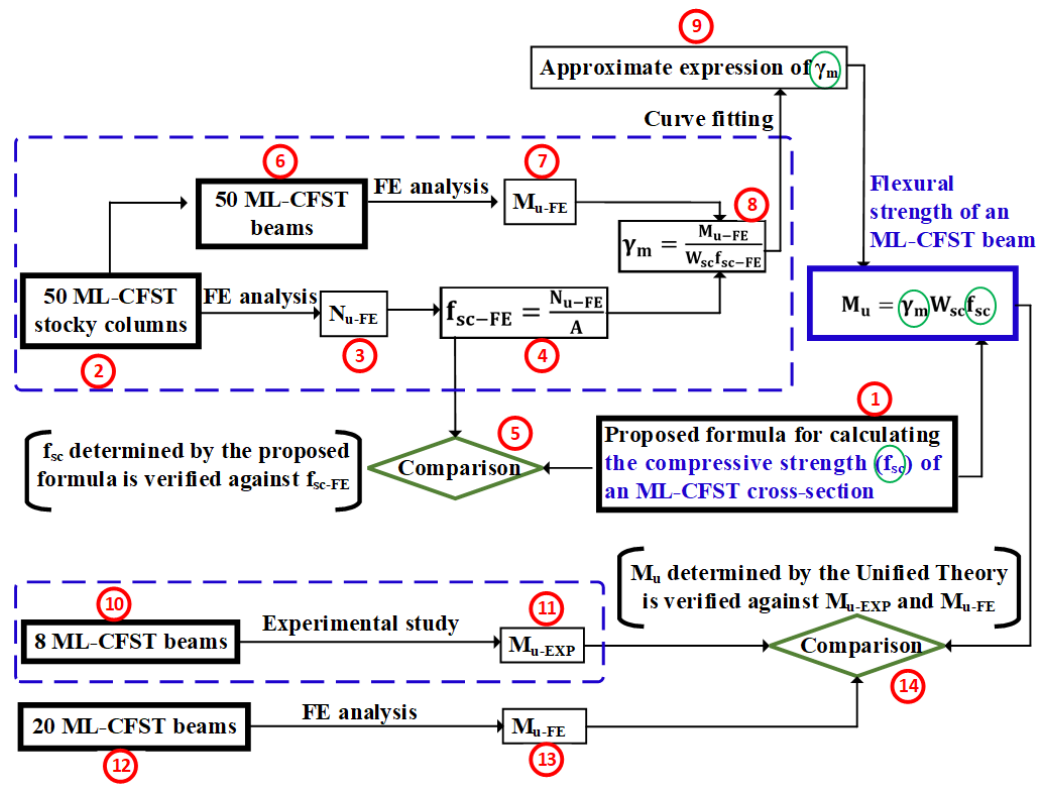
Figure 2. Illustration of the adopted methodology.